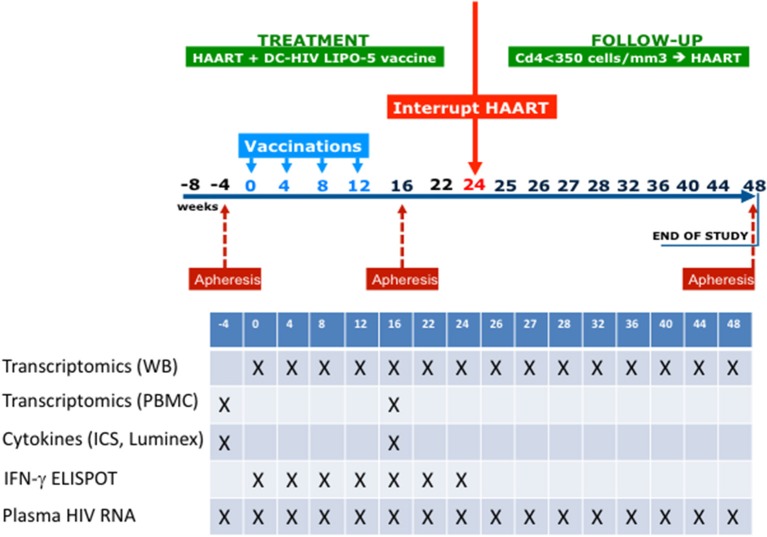
Outline of the ANRS/VRI DALIA 1 clinical trial. Gene abundance in whole blood has been evaluated at any single time point. Gene abundance following PBMC isolation and stimulation has been done with sample coming from baseline (W-4) and after vaccination (W16). At W16, a deep immunological evaluation has been performed with Multiplex, intracellular staining and ELISPOT.